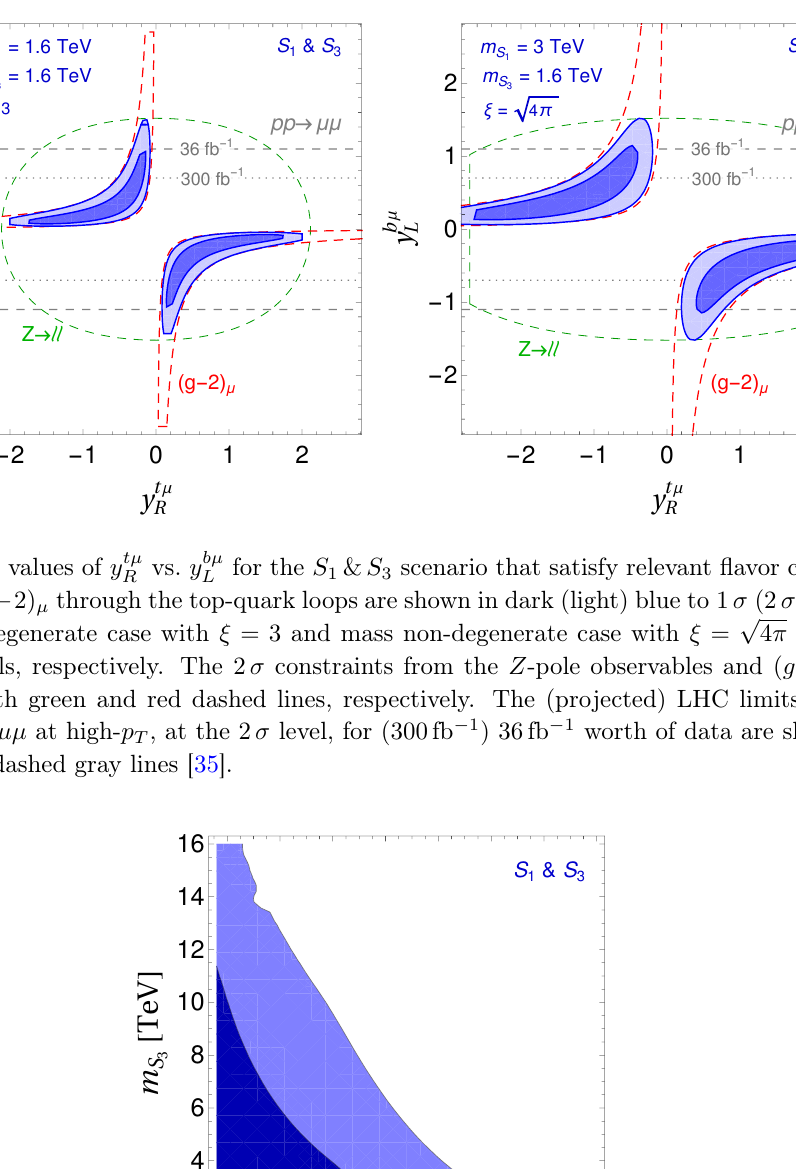
and m S that can address ( g 1 3